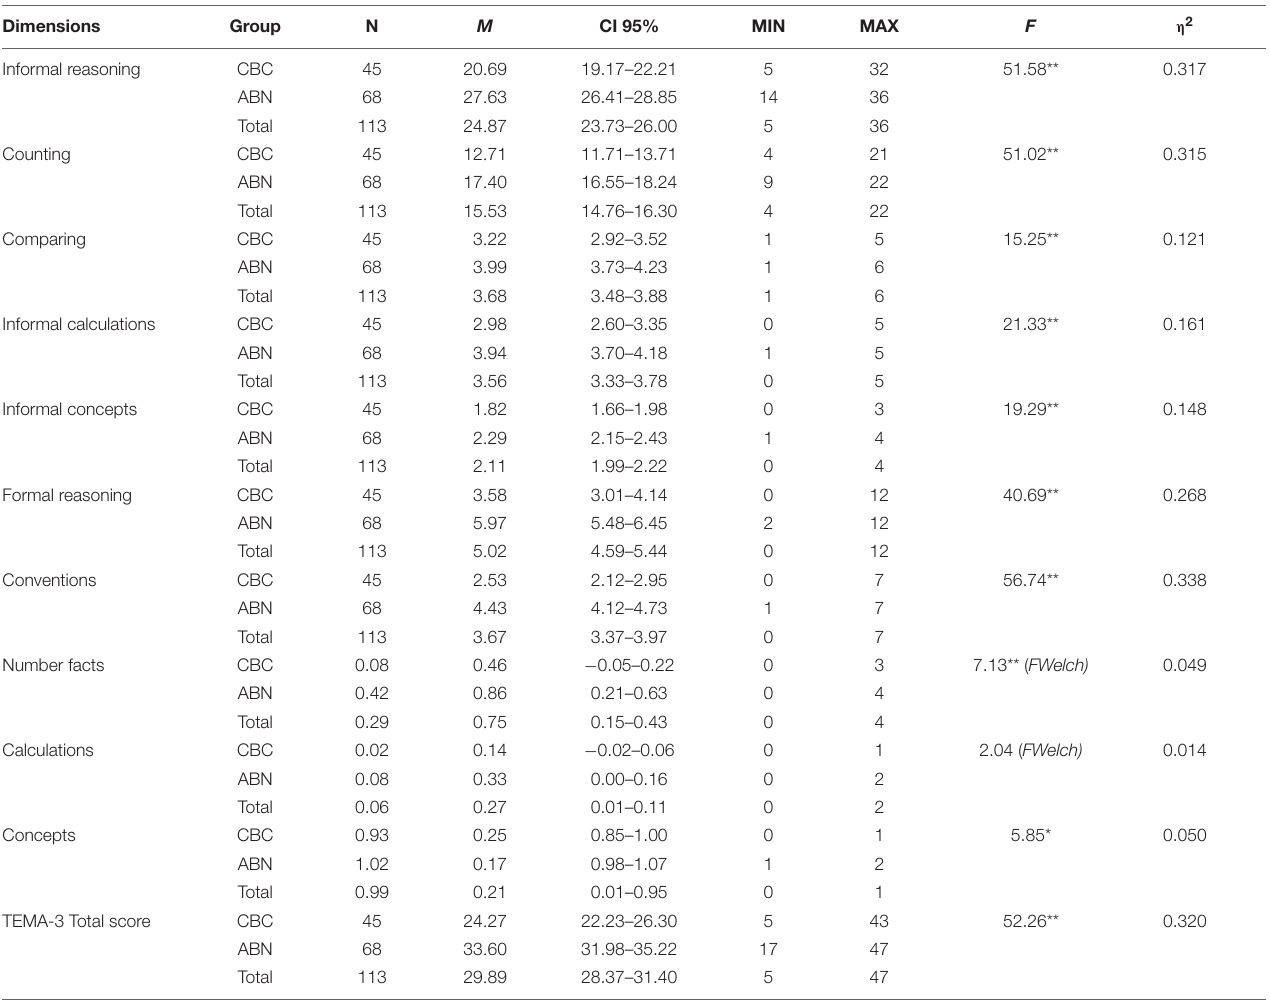
TABLE 3 | ANOVA and effect size results of TEMA-3 dimensions for the 5-year-old CBC and ABN groups. Dimensions